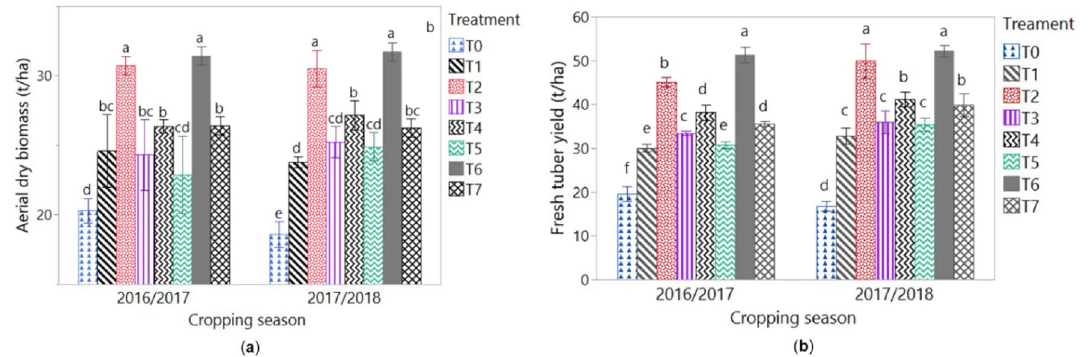
Figure 2. Means of aerial dry biomass ( a ) and fresh tuber yield ( b ) of cassava in 2016/2017 and 2017/2018 cropping seasons. T0 = control (no amendement), T1 = IF : 13-13-23 NPK at 450 t ha −1 + Urea at 100 t ha −1 , T2 = TB at 20 t ha −1 , T3 = TB at 10 t ha −1 , T4 = PM at 20 t ha −1 , T5 = PM at 10 t ha −1 , T6 = TB at 10 t ha −1 + PM at 10 t ha −1 , T7 = TB at 5 t ha −1 + PM at 5 t ha −1 . TM Tithonia diversifolia fresh biomass, PM poultry manure, IF inorganic fertilizer. Values followed by similar letters are not significantly different at p = 0.05.